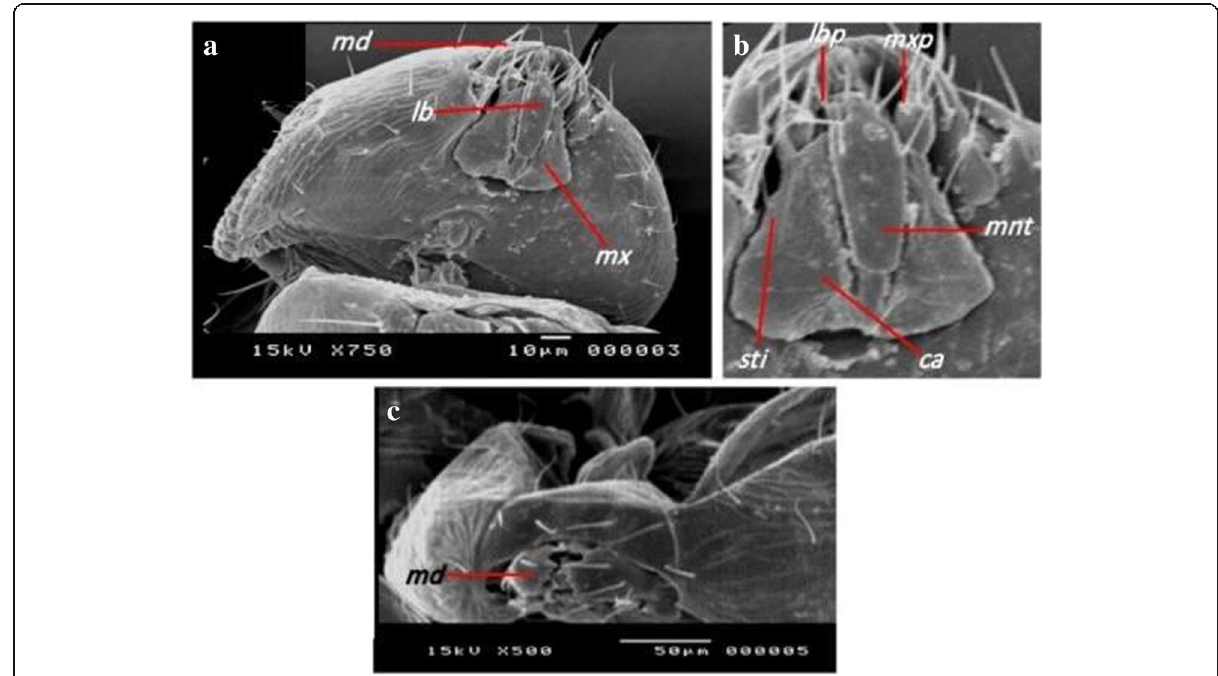
Fig. 4 The mouth parts: a, b SEM of strain TNV ventral view of head capsule with hypognathous type and chewing mouthparts. c Mandibles with undulate margin and spines on internal surface ( mx maxilla, md mandible, mxp maxillary palp, lbp labial palp, ca cardo, ga galea, li ligula, mnt mentum, sti